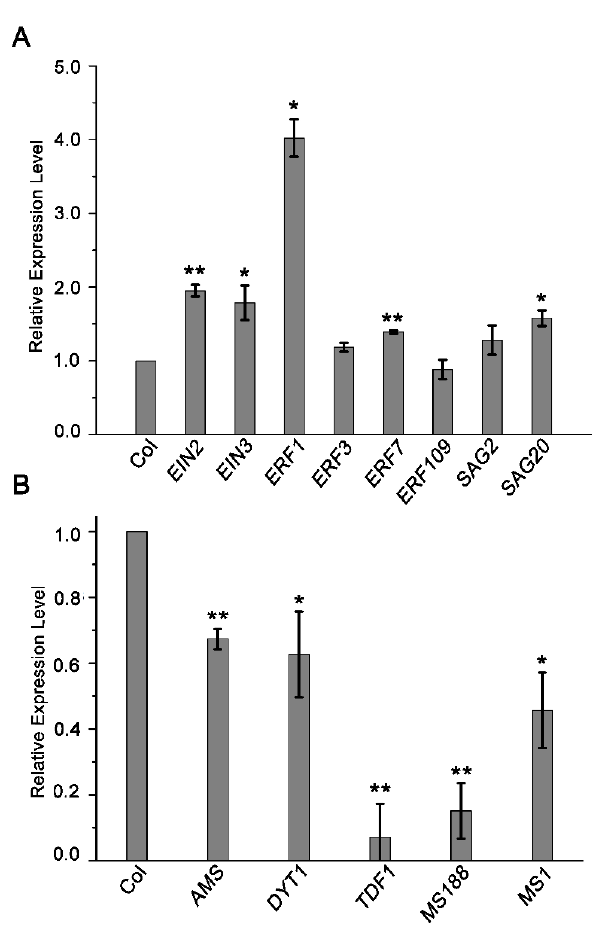
Figure 9. Quantitative RT-PCR analysis of ERFs , SAGs and tapetum development-related key tran- scription factors after ethylene treatment. ( A ) Relative expression of EIN2 , EIN3 , ERFs and SAGs genes in the inflorescence of Col after ethylene treatment for 24 h. ( B ) The expression of the five key transcription factor genes in tapetum development is reduced after ethylene treatment. Relative ex- pression of AMS , DYT1 , TDF1 , MS188 , and MS1 in the inflorescence of Col-0 after ethylene treatment for 24 h. Col treated with air for 24 h was used as a mock. Gene expression was relative to that of the mock. β -tubulin was used as an internal control for normalization. Data are mean ± SEM of 3 biological replicates with technical duplicates for each. * p < 0.05, ** p < 0.01 ( t